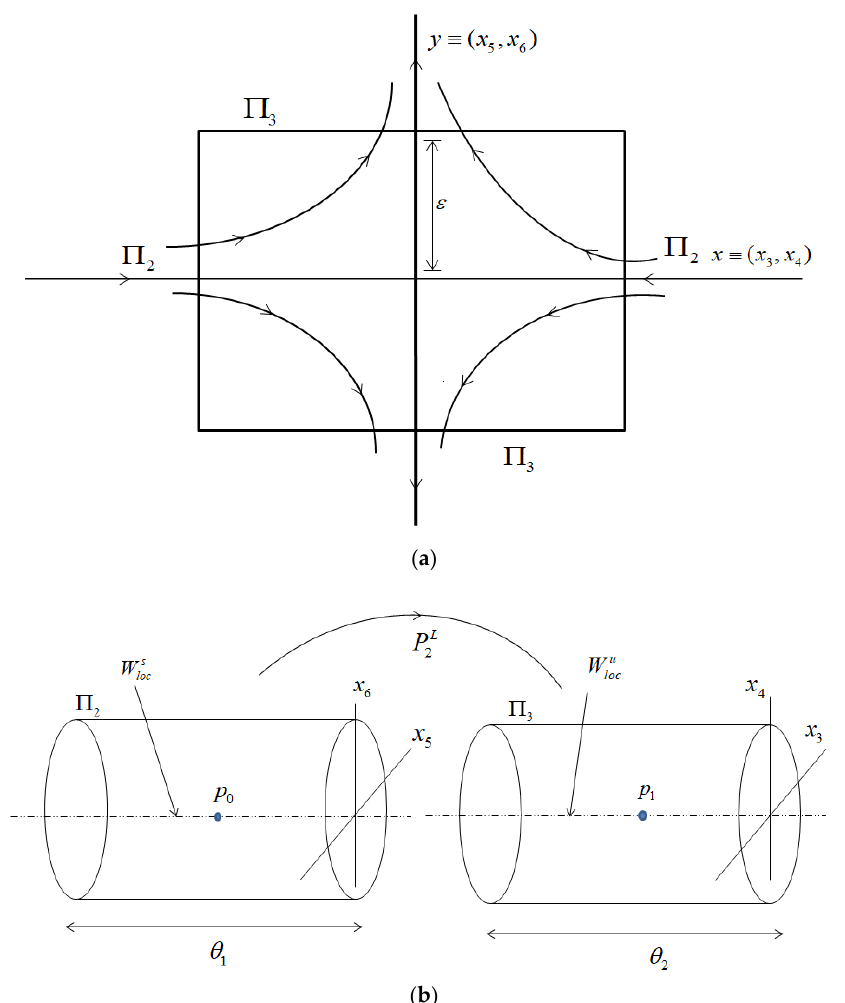
Figure 7. The three-dimensional solid torus structure and cross section of Π 2 and Π 3 . ( a ) The cross section of Π 2 and Π 3 . ( b ) The three-dimensional solid torus structure of Poincare map P L . 2 Figure 7a represents a cross-section diagram taken from two three-dimensional solid torus structure diagrams. Figure 7b describes the process of the